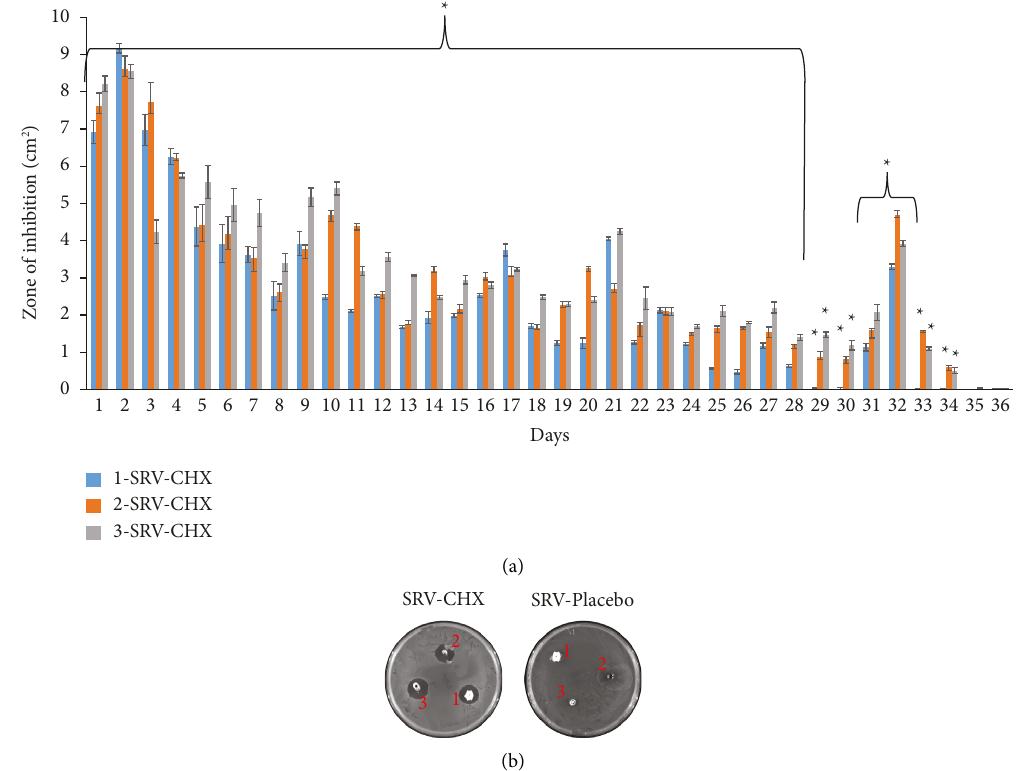
Figure 2: Kinetics of bacterial growth inhibition. Abutments 1, 2, and 3 coated with SRV-CHX (1-SRV-CHX, 2-SRV-CHX, and 3-SRV- CHX) and SRV-placebo were placed on agar plates pre-seeded with 50 microliters S. mutans at OD 595 � 0.02. The plates were incubated at 37 ° C aerobically with 5% CO 2 . The zone of inhibition (ZOI; cm 2 ) around the placed abutments was measured daily, and the abutments were removed aseptically and placed on new S. mutans pre-seeded plates for further incubations. (a) Quantitative analysis of bacterial growth inhibition by SRV-CHX-coated abutments [1–3]. ∗ Significantly higher than the value for SRV-placebo ( P < 0 . 05). (b) Images of inoculated agar plates after 21 days of incubation with an inserted 1-, 2-, or 3-SRV-CHX/placebo-coated